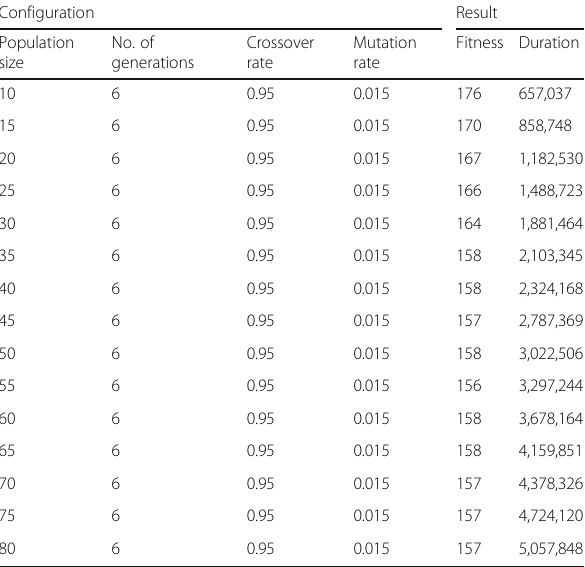
Table 13 Impact of population size on the genetic algorithm accuracy